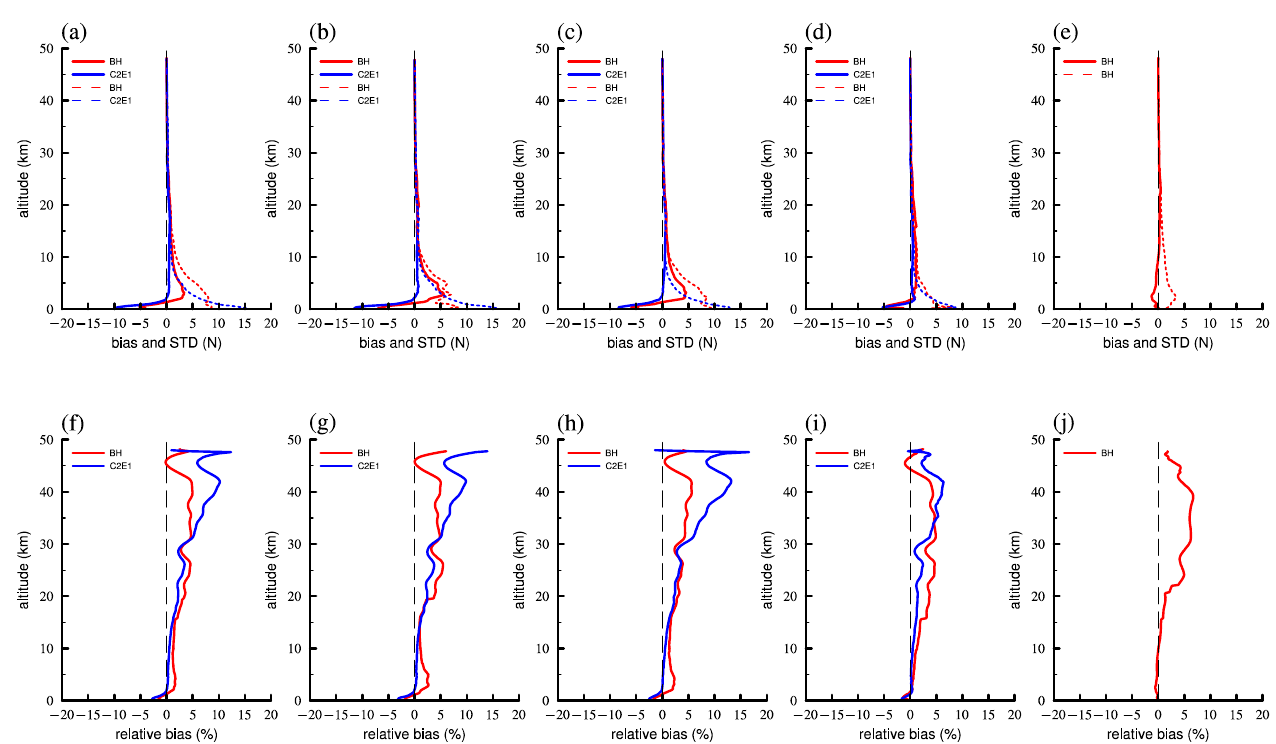
Figure 5. Vertical profiles of the average refractivity bias and STD (top; units: N) and ( f – j ) relative bias (bottom; units: %) for the BH and C2E1 data at different latitudes. ( a – e ) The average refractivity bias in the range of 0–45°, 0–15°, 15–30°, 30–45°, and 45–90°, respectively; ( f – j ) same as ( a – e ) but for the relative bias. The red and blue dashed lines indicate STD values of BH and C2E1, respectively.